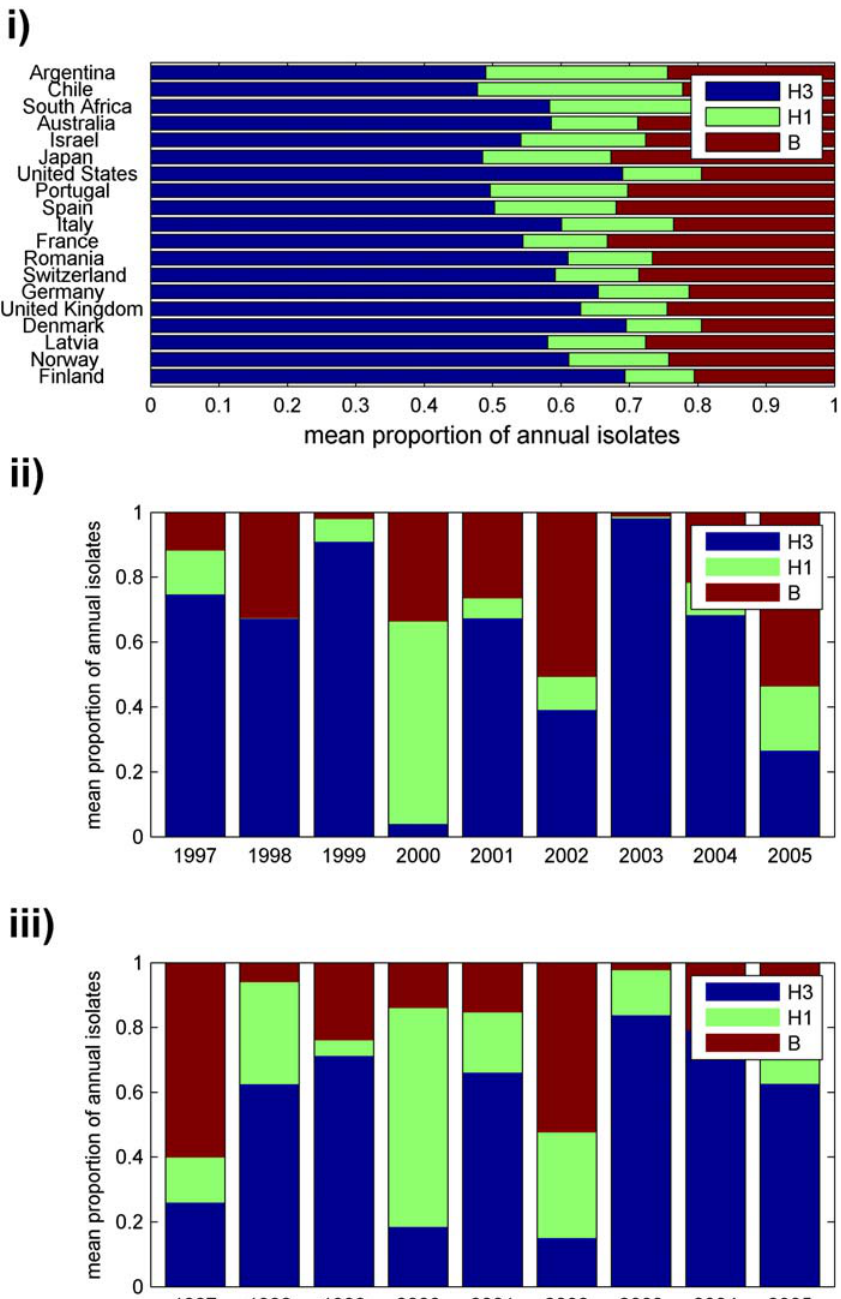
Figure 3. Type and subtype dominance. (i) Mean proportion of annual isolates belonging to each type or subtype, averaged across the nine study seasons, were plotted for each country. (ii–iii) The proportion of annual isolates belonging to each type or subtype was averaged across all countries in both the (ii) Northern and (iii) Southern hemisphere and plotted for each of the nine seasons.